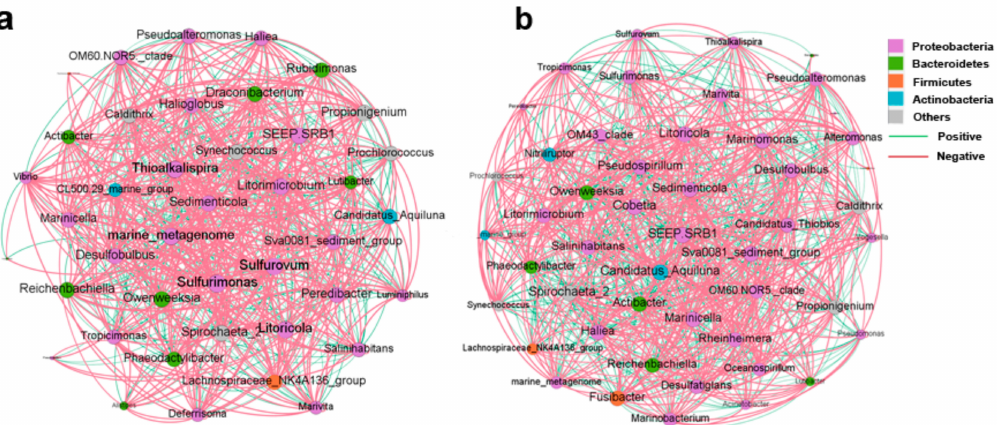
Figure 5. Co-occurrence network of bacterial interactions in both ( a ) FFD and ( b ) FD